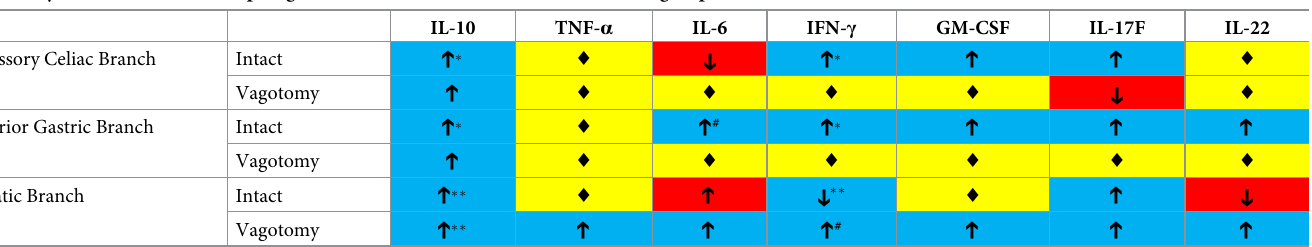
Table 3. Cytokine effects of subdiaphragmatic branch stimulation vs SubD sham subgroup.